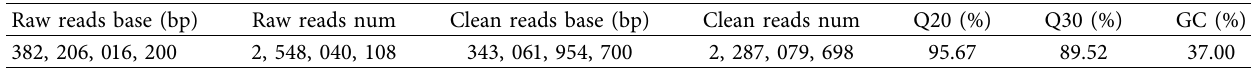
Table 1: Reads statistics of CNC.